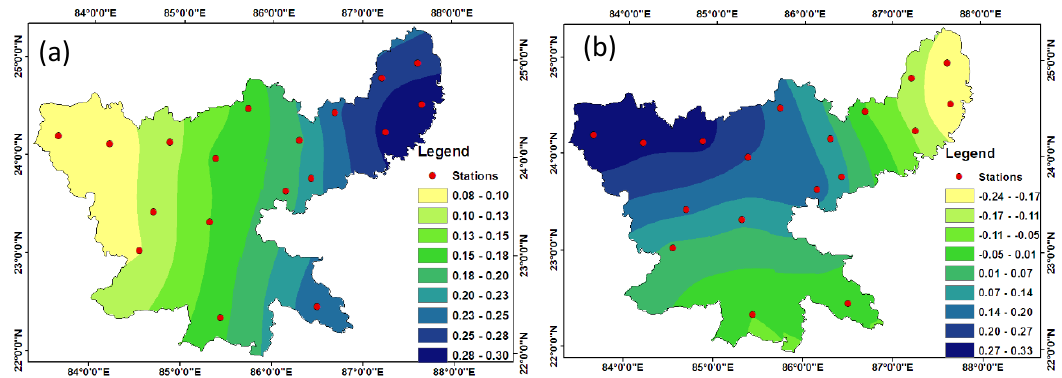
Figure 10. Spatial distribution of temporal change in Post monsoon rainfall during 1901 to 2002 ( a ) and from 1952 to 2002 ( b ).